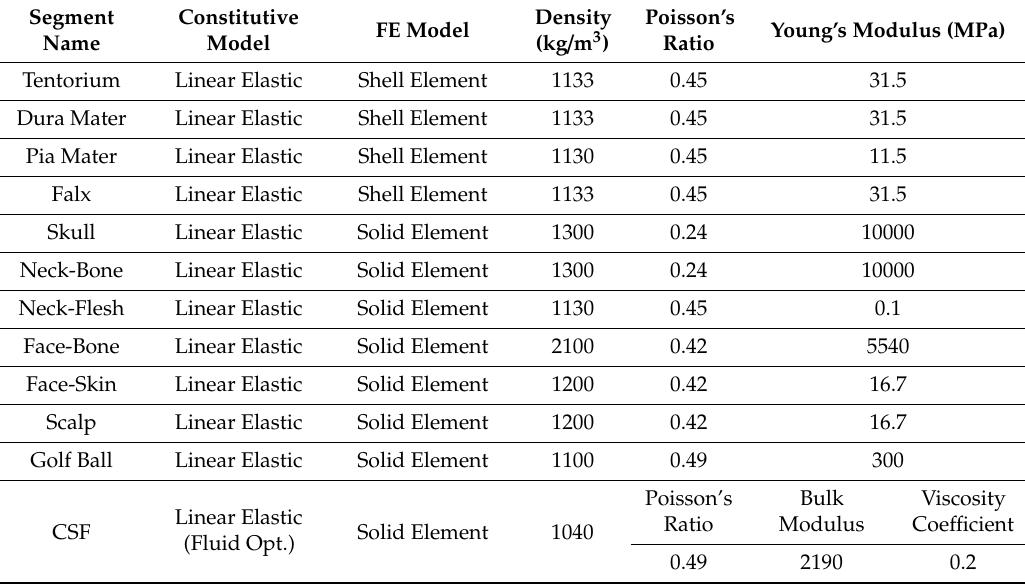
Figure 2. Setup of frontal and lateral impact by golf ball in the FE head model.